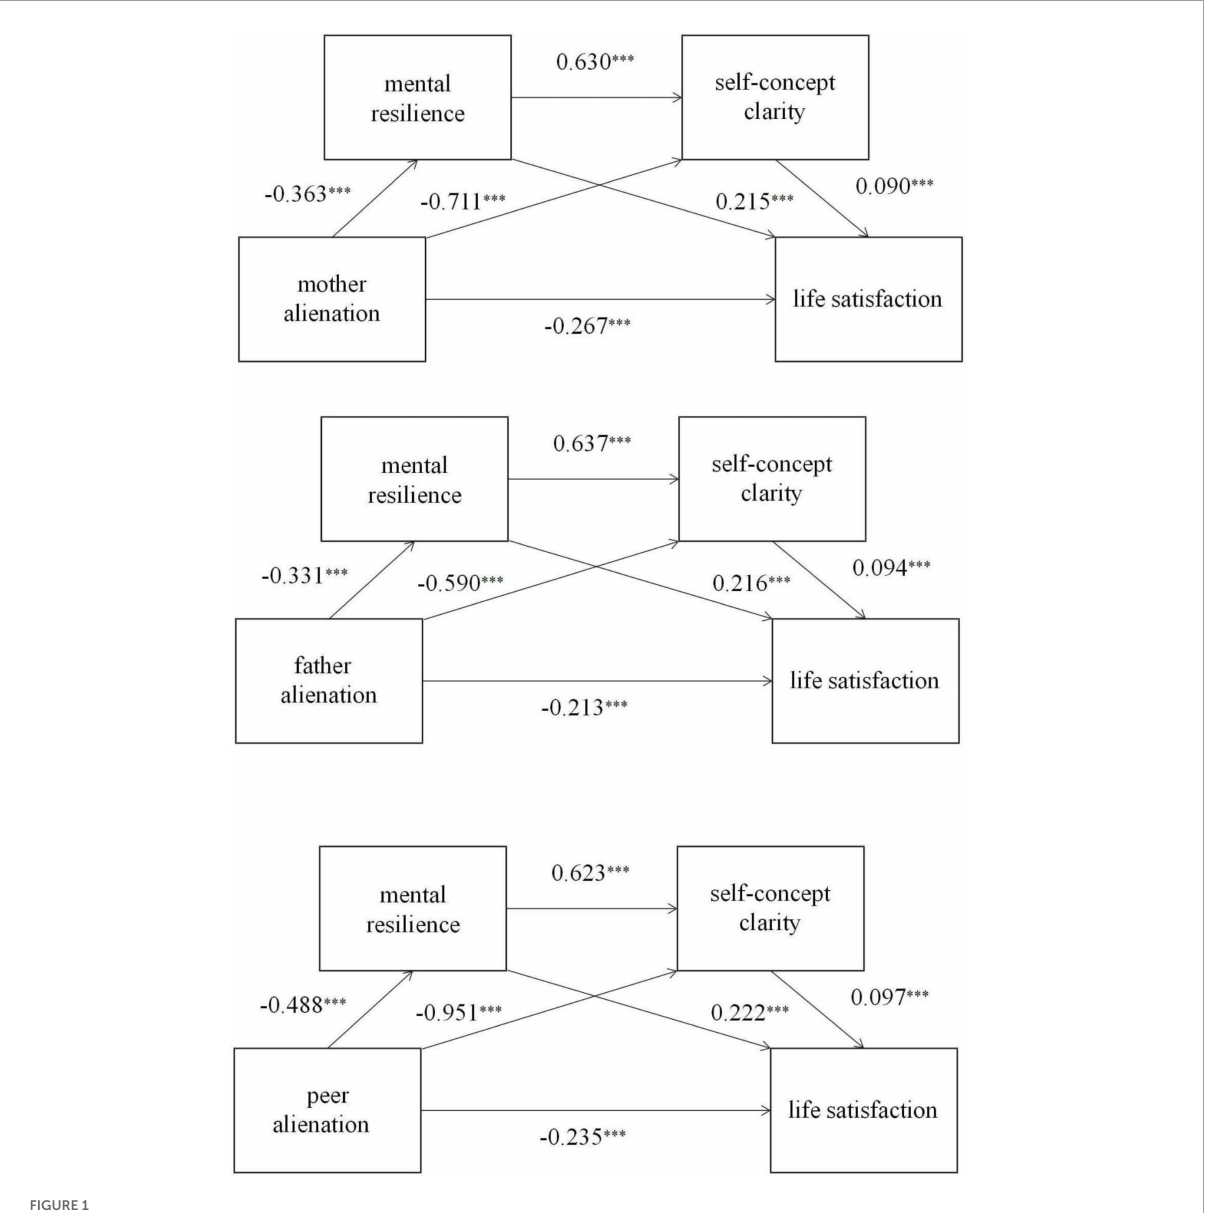
FIGURE1 Chain intermediary model *** p <